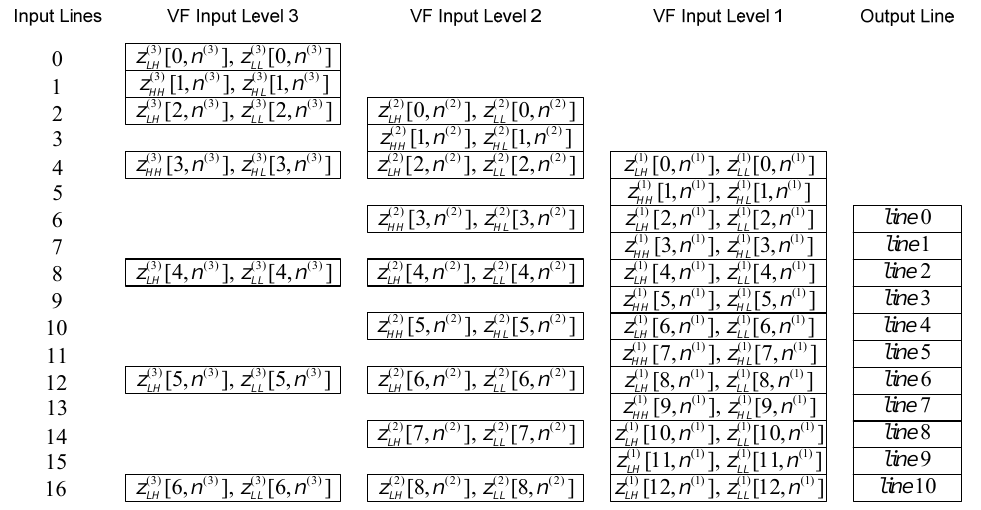
22 of 29 Figure 14. The time diagram of the 2 ‐ D inverse DWT 5/3 filtering at the end of even lines. The time diagram of the 2 ‐ D inverse DWT 5/3 filtering of the odd lines is almost the same as for the even lines. There are only few differences: every even signal component (starting from 0) at the input of vertical filter belongs to the subband HH (